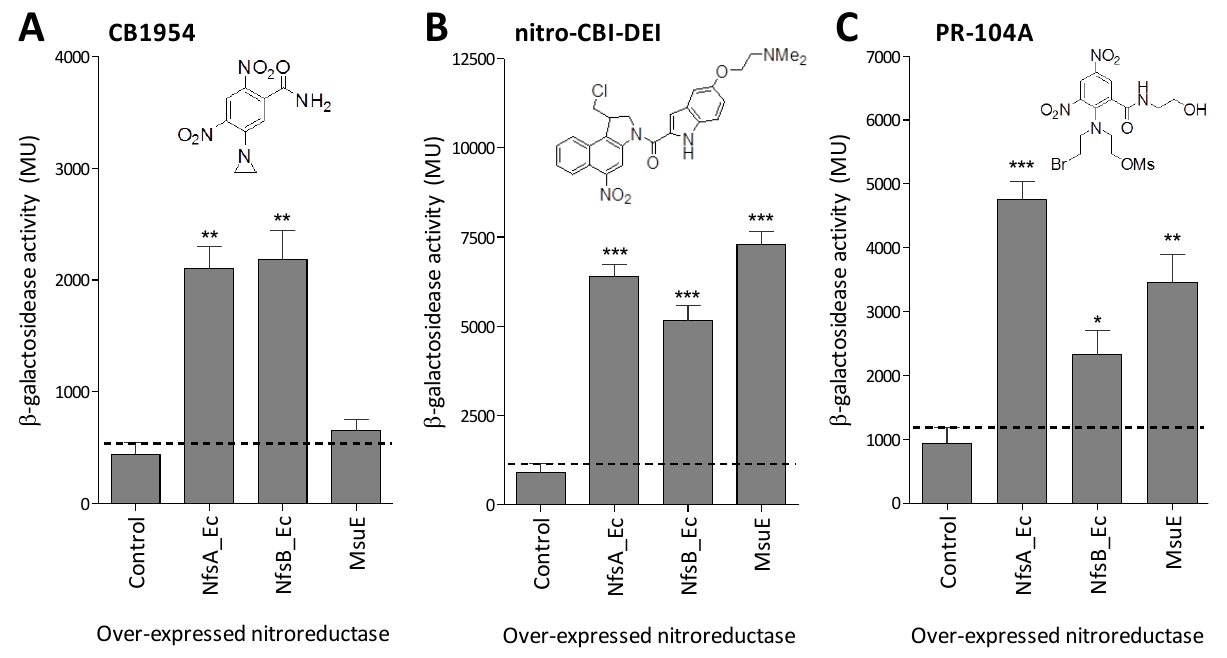
Figure 3. Fold-induction of SOS response in SOS-R2 strains over-expressing NfsA_Ec, NfsB_Ec or MsuE upon challenge with CB1954, nitro-CBI-DEI or PR-104A. SOS-R2 reporter strains over-expressing nfsA_Ec , nfsB_Ec or msuE , or containing an empty pUCX plasmid control, were incubated for 3 h in the presence of ( A ) 20 µM CB1954; ( B ) 5 µM nitro-CBI-DEI; or ( C ) 40 µM PR-104A (structures inset); after which relative induction of the SOS response in each strain was measured by β-galactosidase assay as previously described [13]. Data are the mean Miller units from three independent experiments, each performed in duplicate; and error bars are ± 1 standard deviation. The black dotted line indicates the upper error limit of basal SOS activity in the empty plasmid control. * indicates p < 0.05, ** indicates p < 0.005, *** indicates p < 0.001 (one-way ANOVA with Dunnett comparison of test to